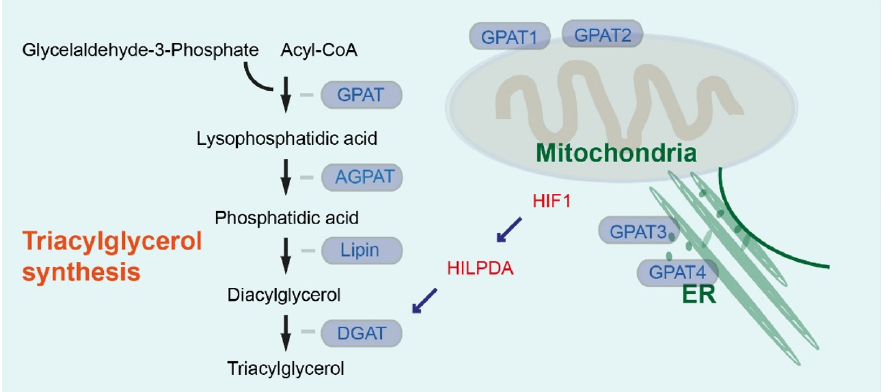
Figure 1. Substrates and key enzymes in triacylglycerol synthesis. AGPAT: Acylglycerolphosphate acyltransferase, DGAT: Diacylglycerol acyltransferase, ER: Endoplasmic reticulum, GPAT: Glycerol-3-phosphate acyltransferase.